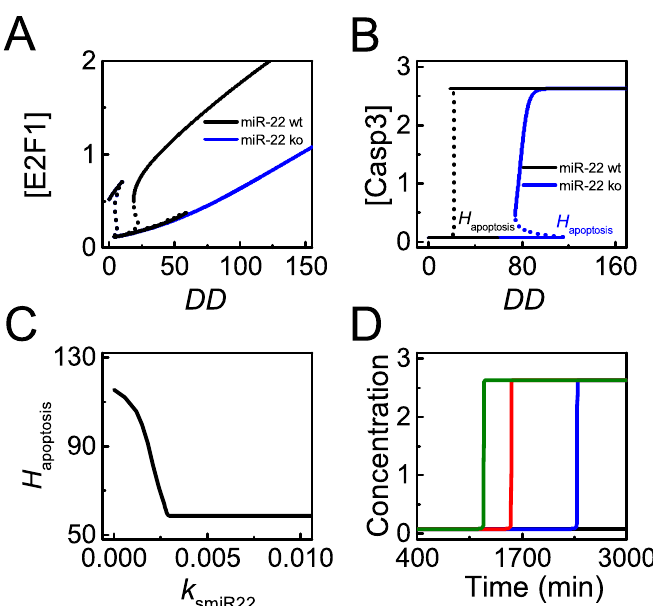
Figure 7. miR-22 sensitizes cells to p53-dependent apoptosis induced by DNA damage. ( A , B ) bifurcation diagram of [E2F1] ( A ) or [Casp3] ( B ) versus DD with the p53-induced synthesis rate of miR-22, k smiR22 = 0.0075 (black, the default case) and 0 (blue), respectively. The threshold of DD for apoptosis is denoted by H apoptosis ; ( C ) the curve of H apoptosis versus k smiR22 ; ( D ) time courses of [Casp3] with k smiR22 = 0.015 (green), k smiR22 = 0.0075 (red, the default case), k smiR22 = 0.0045 (blue), and k smiR22 = 0.0015 (black) at DD =